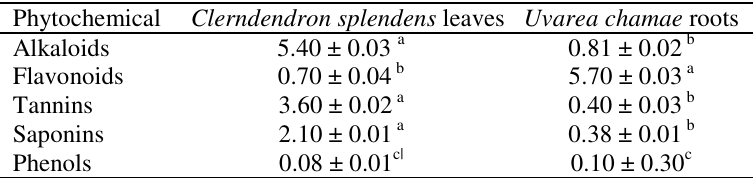
Table 1. Phytochemical composition of Clerodendron splendens leaves and Uvarea